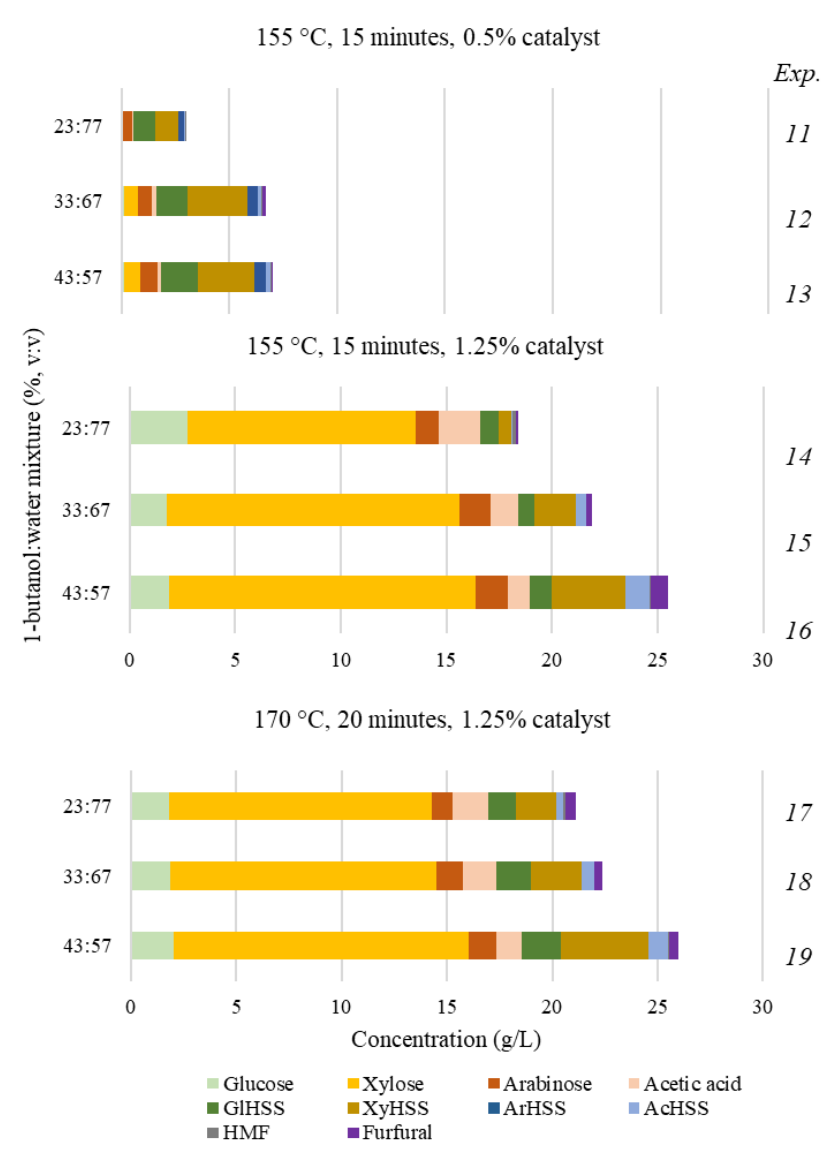
Figure 3. Concentrations of polysaccharide-derived products in the aqueous phases from EF.AD processing obtained in experiments 11–19 in Table 3. Nomenclature: GlHSS, anhydroglucose units in higher soluble saccharides; XyHSS, anhydroxylose units in higher soluble saccharides; ArHSS, anhydroarabinose units in higher soluble saccharides; AcHSS, acetyl groups attached to higher soluble